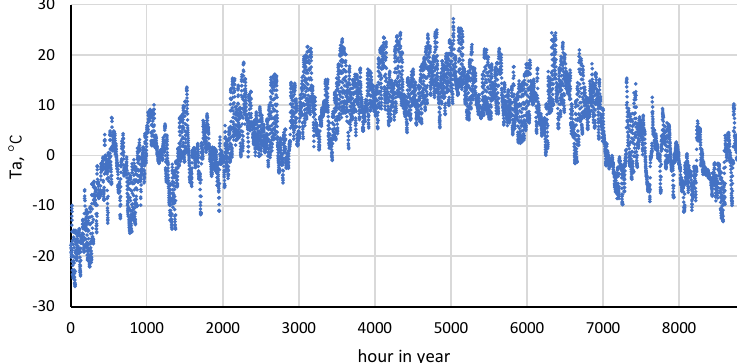
Figure 5. Outside temperature in Zakopane according to Typical Reference Year. Source: own study, based on [52]. Data on the heat demand for the preparation of domestic hot water were divided according to hours based on data from work [53].